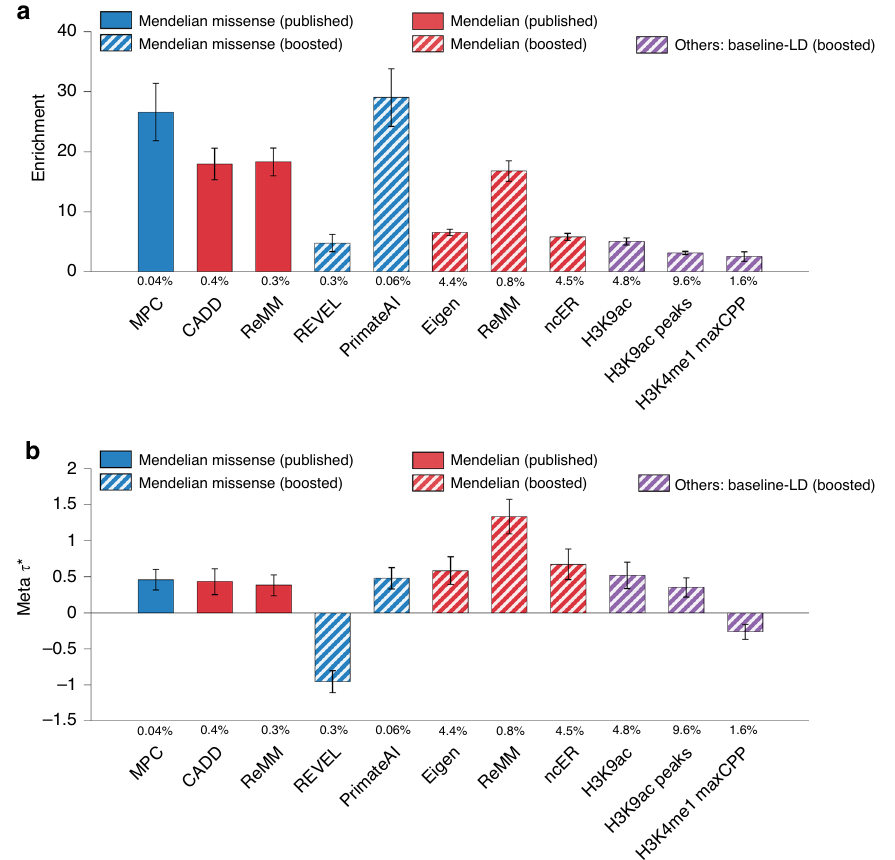
Fig. 4 Informativeness for a common disease of 11 jointly signi fi cant binary annotations from combined joint model. We report ( a ) heritability enrichment of 11 jointly signi fi cant binary annotations, meta-analyzed across 41 independent traits; b joint τ * values, conditioned on the baseline-LD model, eight Roadmap annotations, and each other. We report results for the 11 jointly conditionally informative annotations in the combined joint model (S-LDSC τ * P < 0.0001 and ∣ τ * ∣ ≥ 0.25). The percentage under each bar denotes the proportion of SNPs in the annotation. Error bars denote 95% con fi dence intervals. Numerical results are reported in Supplementary Data 19. Results for standardized enrichment, de fi ned as enrichment times the standard deviation of annotation value (to adjust for annotation size), are reported in Supplementary Data 23.